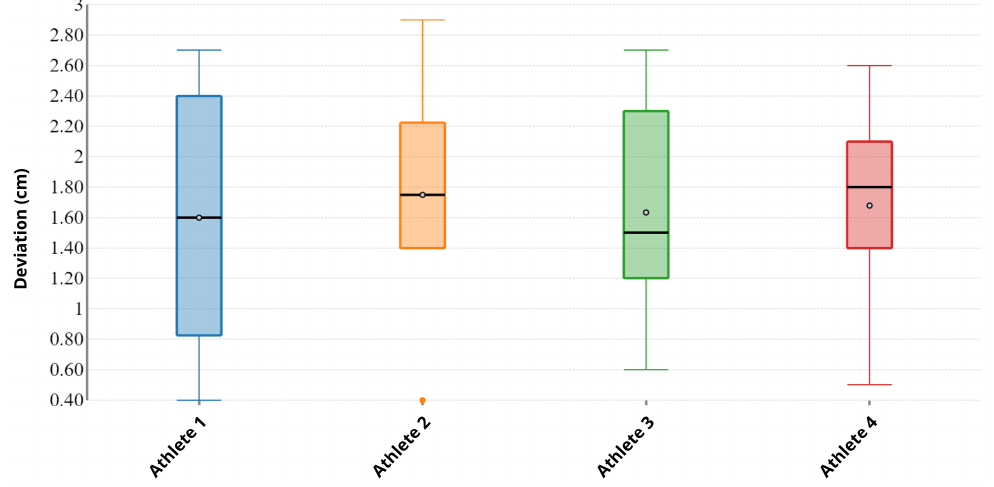
Figure 5. A box plot of the deviations between the sensor data and the belt reference measurement for each athlete. Empty dots represent the mean and black segments are the median. Despite the different physical characteristics of the athletes, the deviations were quite stable, with an overall mean of around 1.61 cm and a relatively low variance. Table 3. Squat jump measurements: the min/max/avg heights read from the sensors; the average reference height read from the Abalakov belt; the min/max/avg deviation between the data from the sensors and the belt; the variance of the deviations;